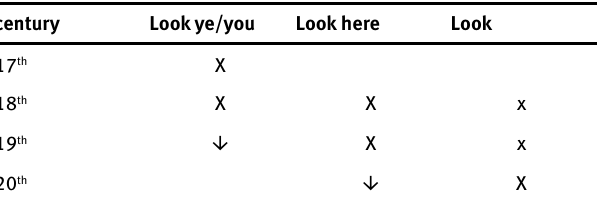
Table 1. Timeline for entrenchment of metatextual Look